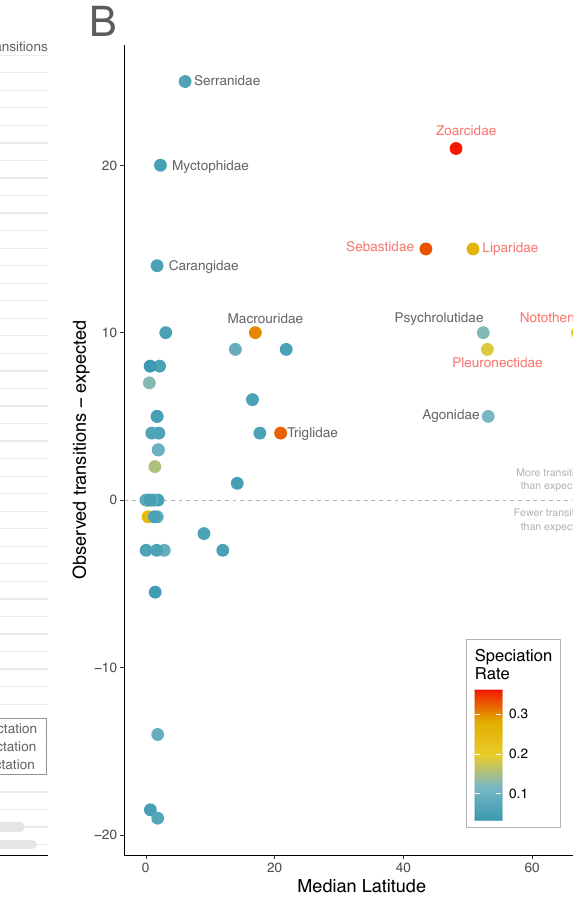
(Fig.4 and Fig. S7). Tropicallatitudeshave signi fi cantly greatervalues of PCD than higher latitudes. Therefore, in tropical latitudes the shallow fi sh community strongly differs from the deeper fi sh com- munity, re fl ecting limited diversi fi cation along the depth axis. High- latitude communities appear more phylogenetically homogenous along the depth axis, re fl ecting repeated invasions of new depth zones. These trends are not driven solely by global patterns in spe- cies richness, as we fi nd a relatively weak relationship between spe- ciesrichnessandPCD( r 2 = 0.28;Fig.S8).We fi ndthatPCDvaluestend to be higher in coastal regions. This pattern may re fl ect sampling bias, as these regions are more likely to be subjected to fi shing efforts, which may in fl ate the estimates of diversity found in coastal,